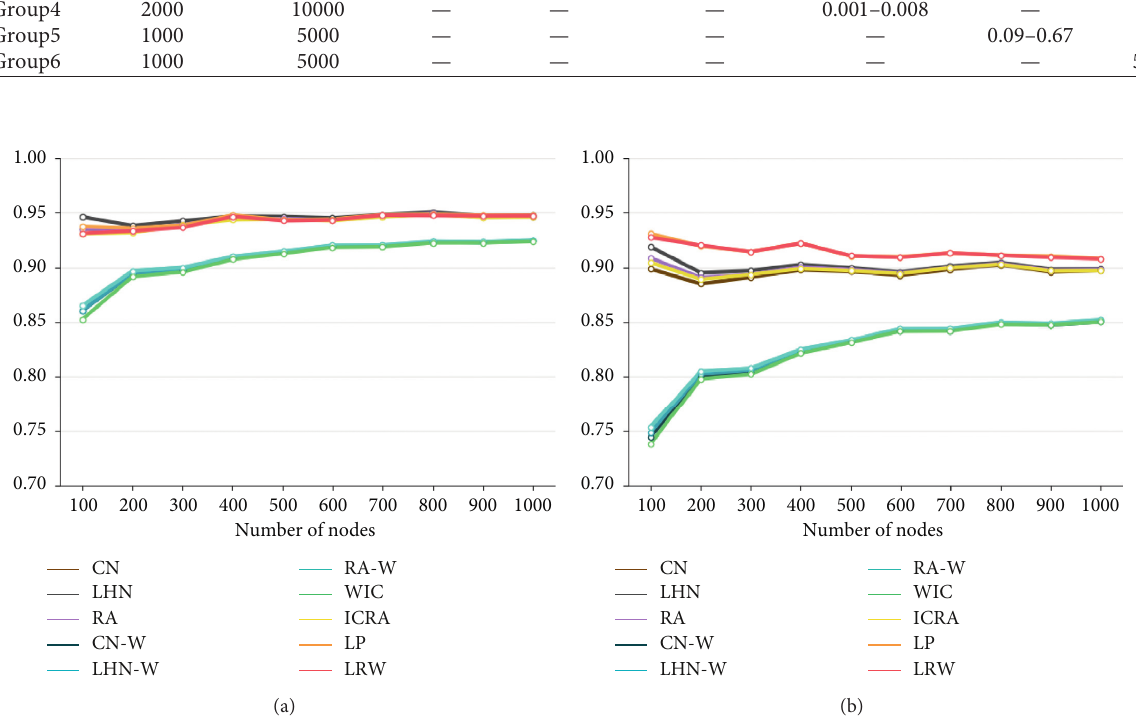
Figure 6: Performance of each predictor under AUC and W-index in WS-Group1. (a) Accuracy measured by AUC. (b) Accuracy measured by W-index.